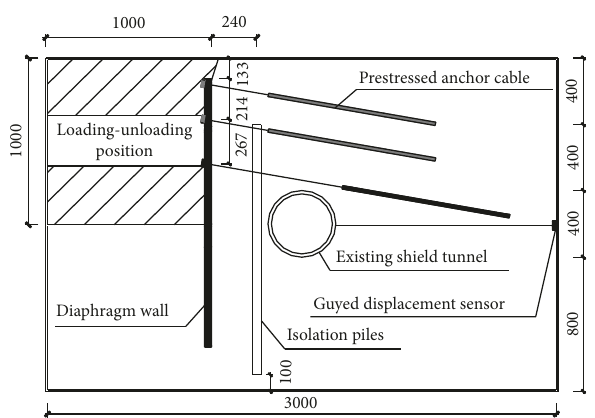
Figure 6: Layout of the support structure and sensor arrangement mode in schemes 2 and